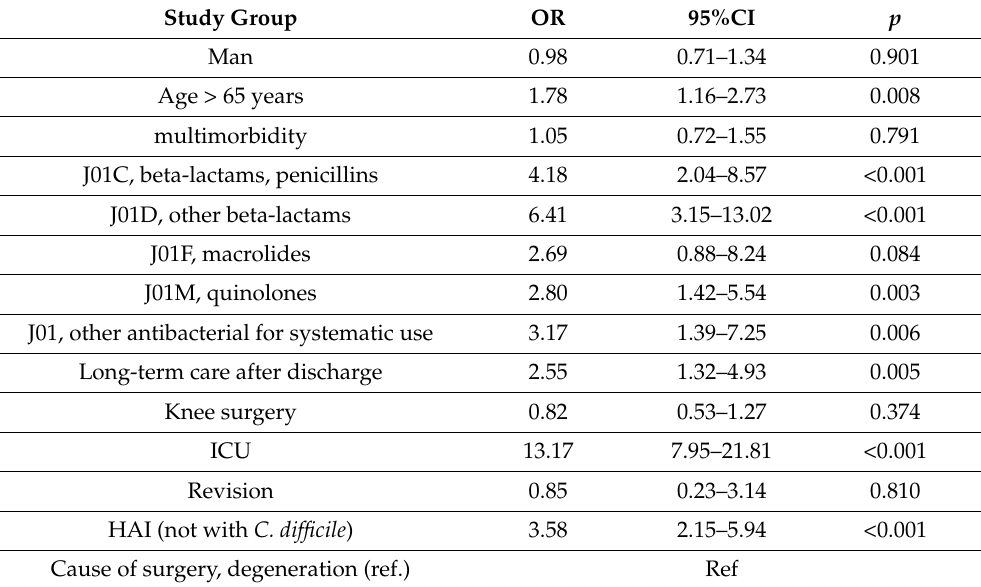
Table 3. Multivariable analysis of the influence of the studied factors on the incidence of